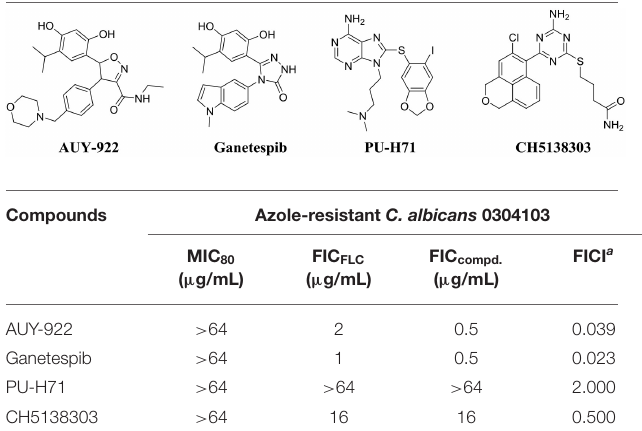
TABLE 2 | In vitro antifungal activity of Hsp90 inhibitors used alone or in combination with FLC against azole-resistant C. albicans strain